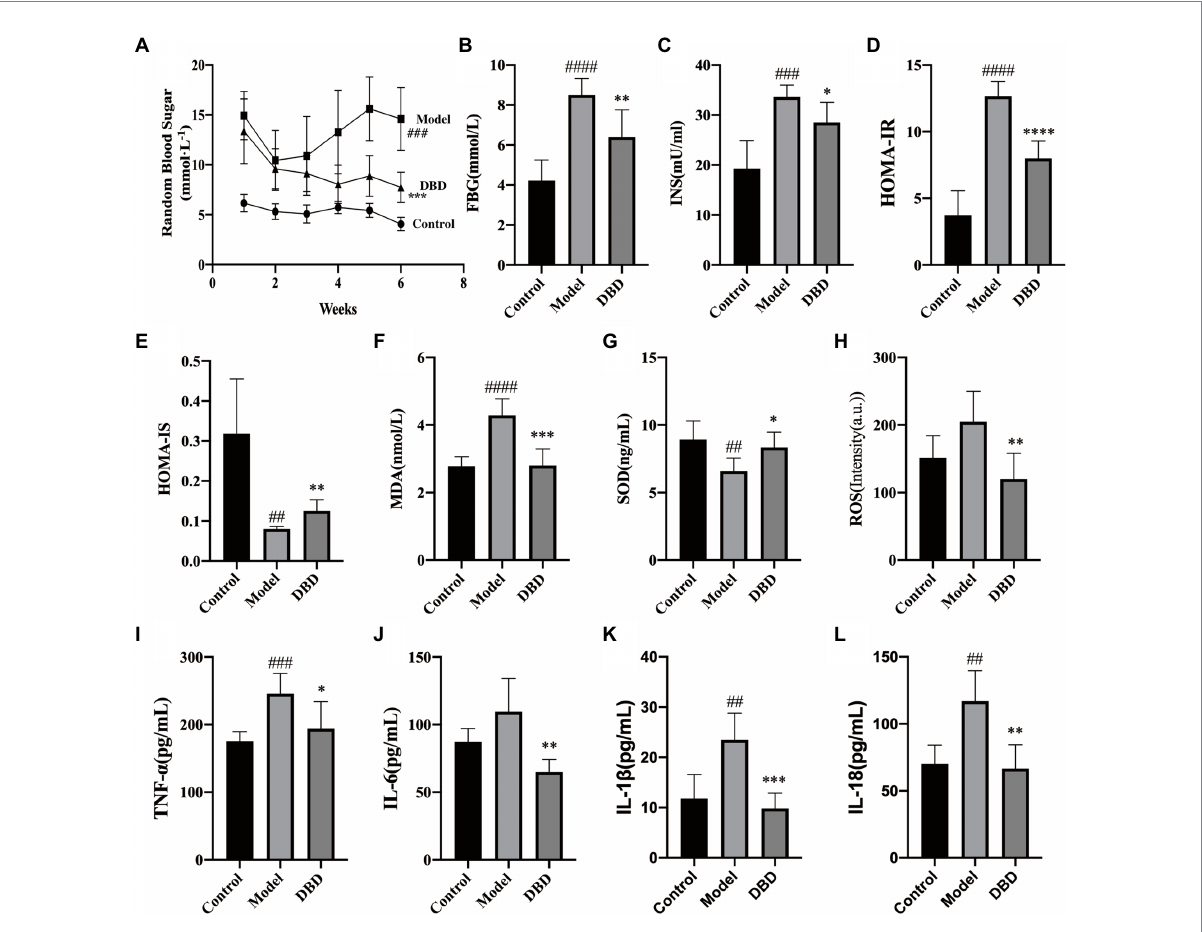
FIGURE 2 The effects of DBD on the blood sugar, insulin, serum oxidative stress, and inflammation cytokine. (A) Random blood sugar of rats at 6 weeks. (B) Concentration of the fasting blood-glucose. (C) Concentration of the blood serum insulin. (D) Levels of HOMA-IR. (E) Levels of HOMA-IS. (F) Concentration of the blood serum MDA. (G) Concentration of the SOD. (H) Levels of ROS. (I) Concentration of the inflammatory cytokine TNF- α . (J) Concentration of IL-6. (K) Concentration of the IL-1 β . (L) Concentration of IL-18. Data are presented as MEAN values ± SD, n = 6. Statistical analysis was done by student’s t test. Compared to control group ## p < 0.01, ### p ≤ 0.005, #### p ≤ 0.001; compared to model